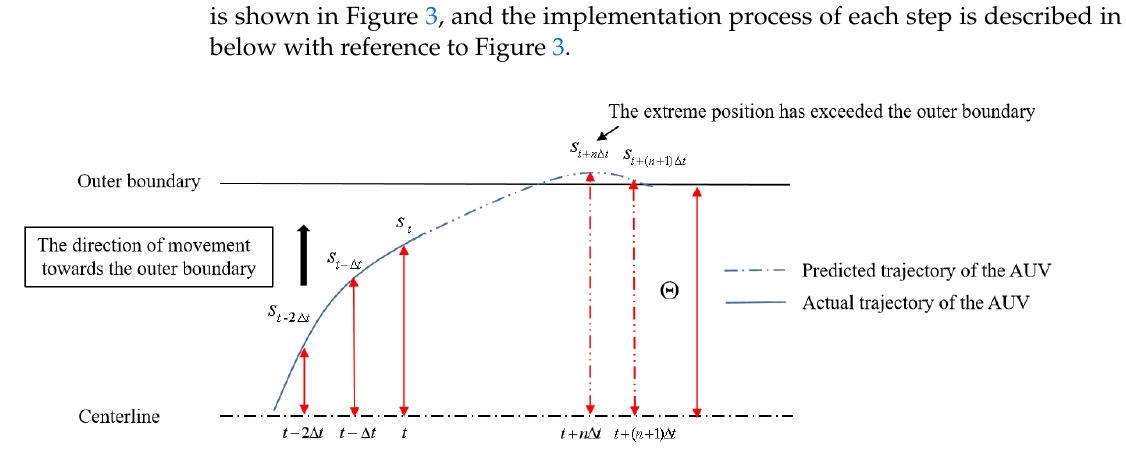
Figure 3. The relationship of parameters in the PRTC scheme.